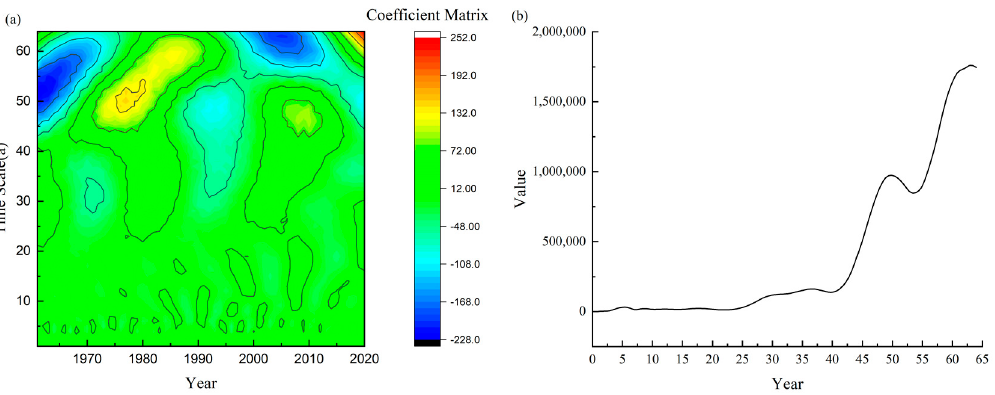
Figure 7. Contour map of the real part of the wavelet coefficients ( a ) and the wavelet variance ( b ) of the potential evapotranspiration in Xinjiang.